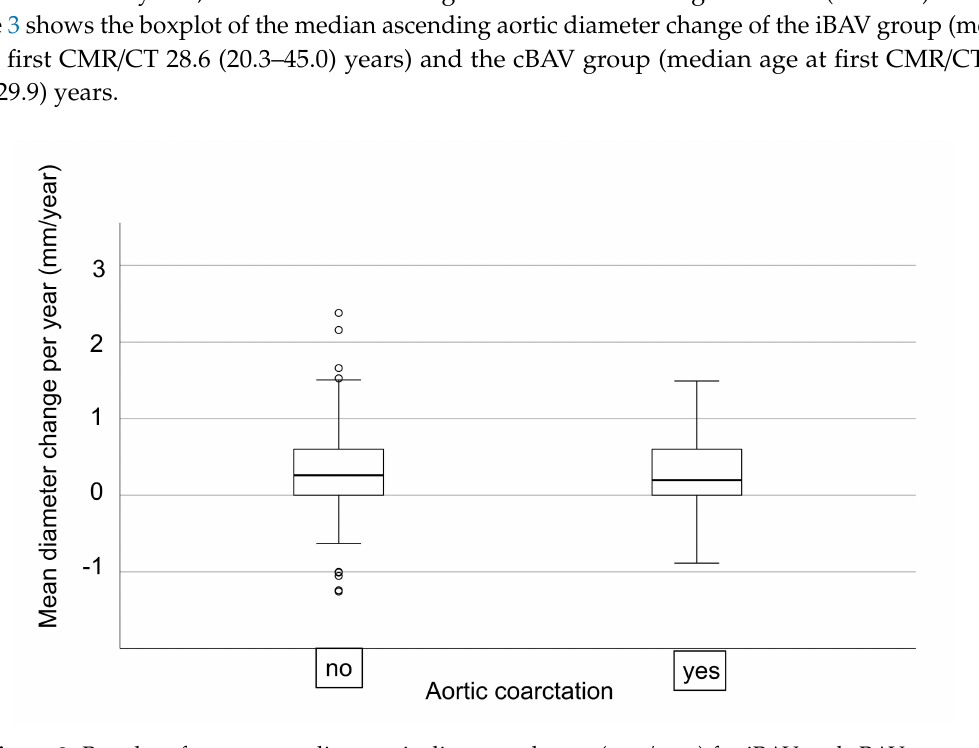
Figure 3. Boxplot of mean ascending aortic diameter change (mm / year) for iBAV and cBAV groups, calculated from 162 unique patients with more than one CMR /